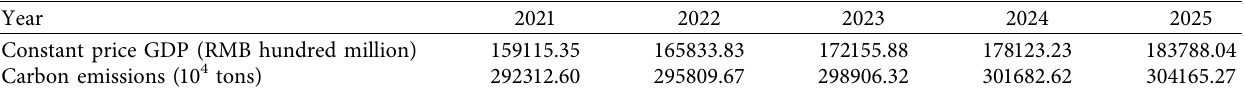
Figure. 1: Actual carbon emissions and predicted curves: MGM(1,2), FMGM(1,2), EGM(1,1), and EFMGM(1, 2). Table 4: Forecast value of Constant price GDP and Carbon emissions in the next five